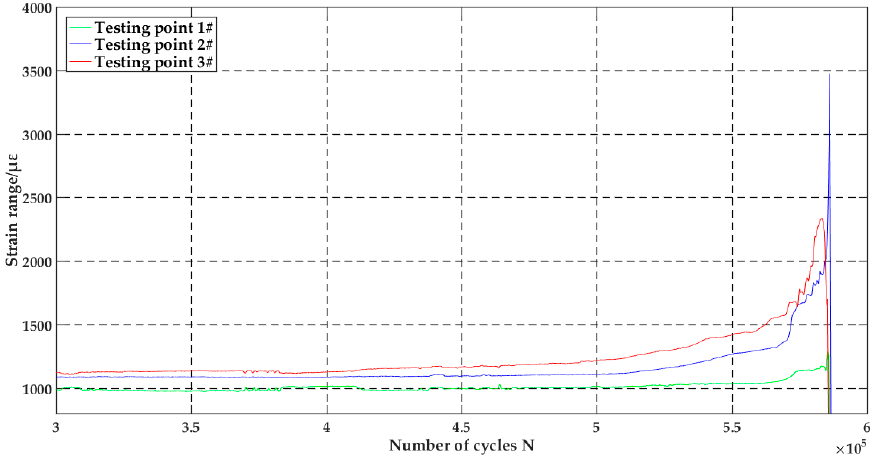
Figure 17. Strain range curve of the final phase.